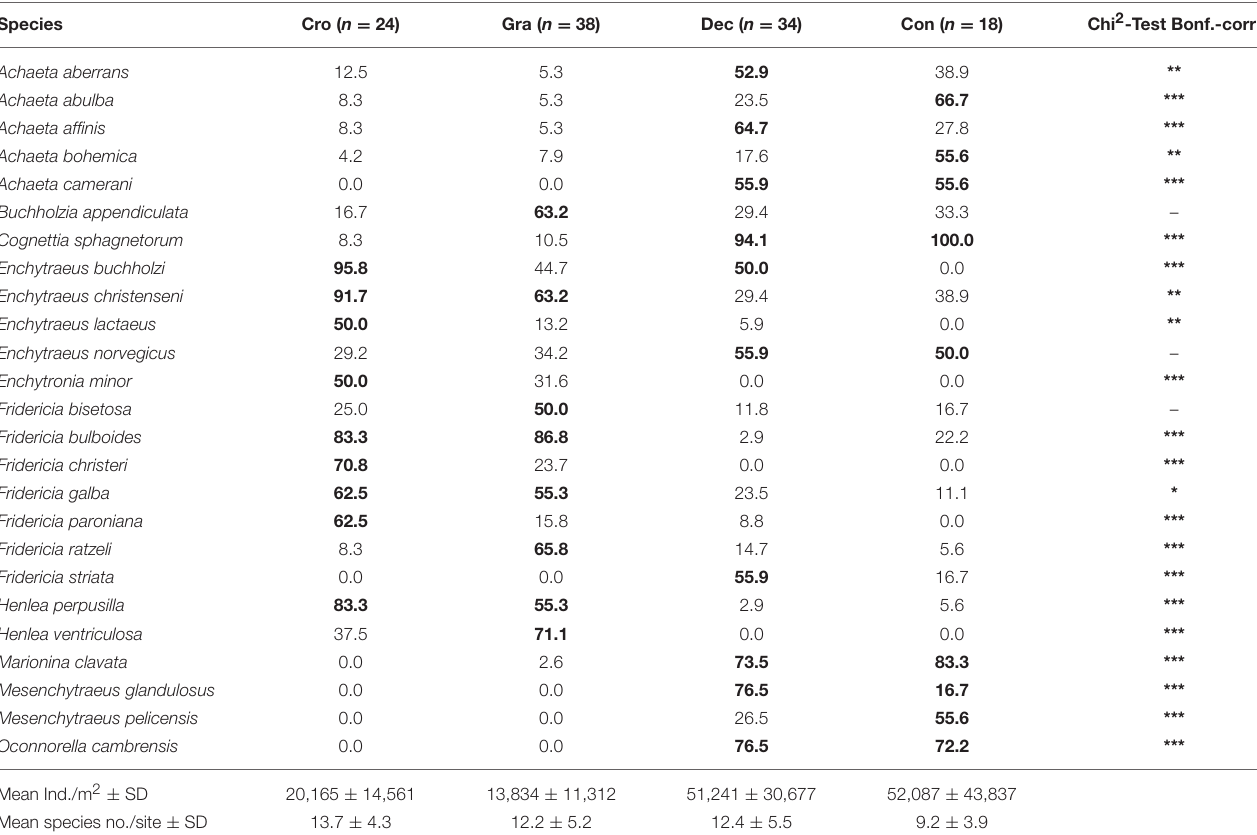
TABLE 1 | Species number, species composition, and percentage of species occurrence of enchytraeids at four land-use forms/habitat types in Germany (1st hierarchal level of habitat classification, juveniles not included), from Römbke et al. (2013).